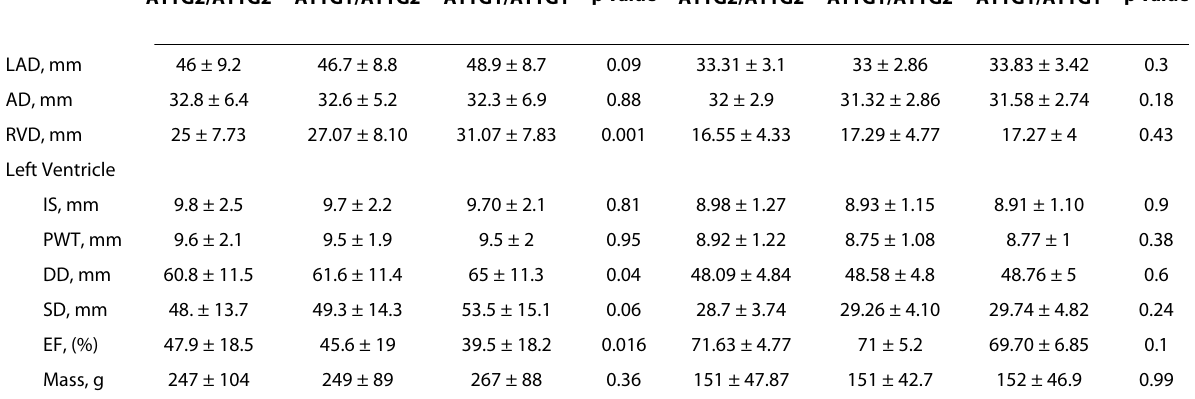
Table 4: Functional data for the HF and Control population according to -94 insertion/deletion genotype. Patients Controls ATTG2/ATTG2 ATTG1/ATTG2 ATTG1/ATTG1 p value ATTG2/ATTG2 ATTG1/ATTG2 ATTG1/ATTG1 p value